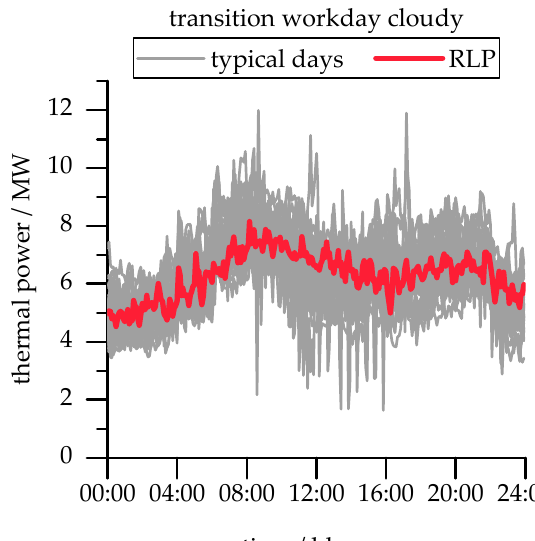
Figure 5. Reference load profile for the typical day category ÜWB.